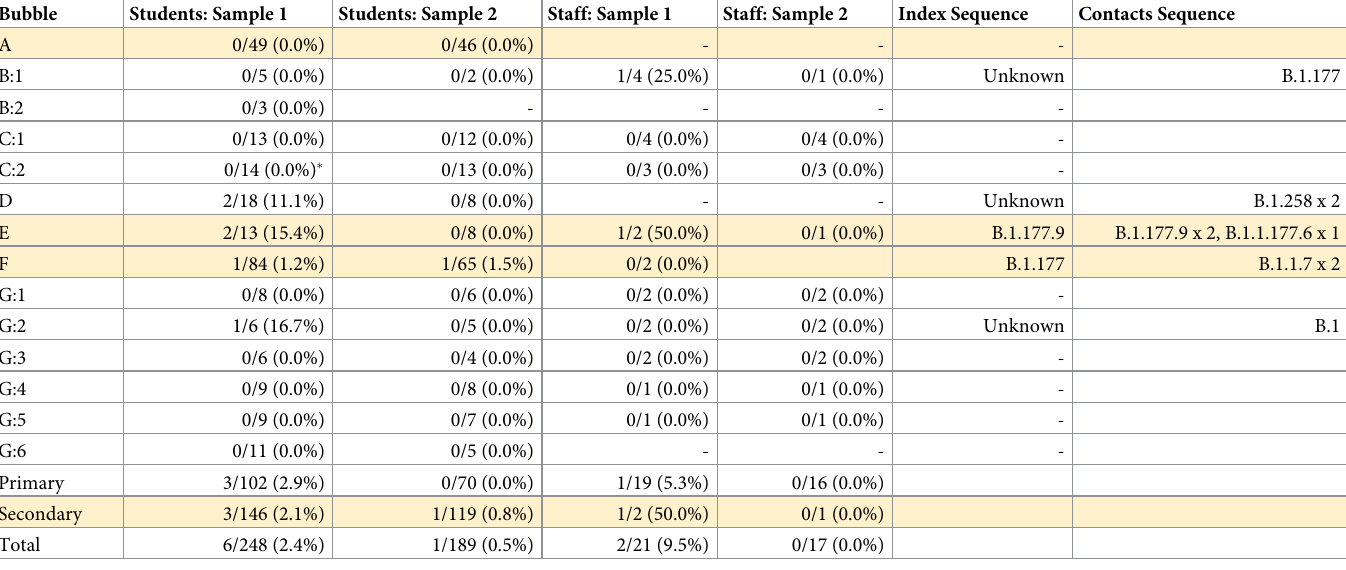
Table 2. RT-PCR and sequencing results of student and staff contacts by